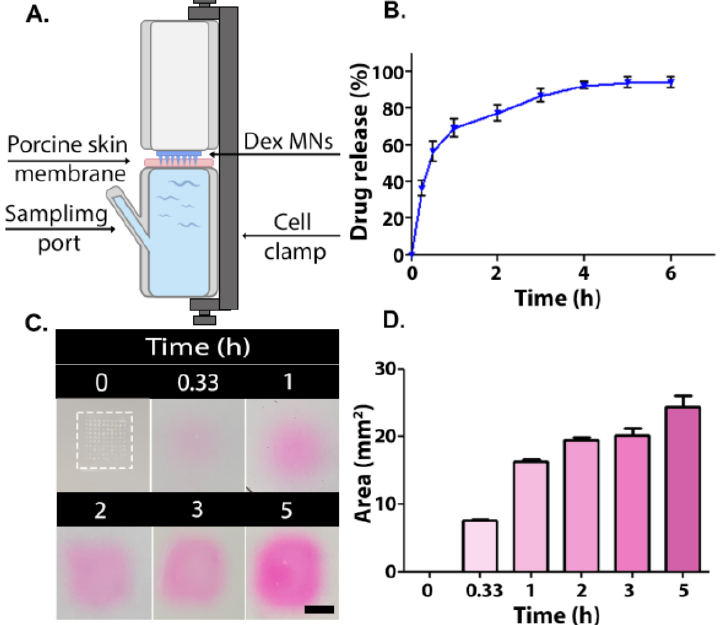
Figure 3. ( A ) Schematic illustration of a Franz di ff usion cell. Release of active ingredient from MNs: ( B ) In vitro Dex release profile from 1:2 PVA/PVP microneedles (n = 4). ( C ) Gel images of rhodamine B release in pig skin gelatin (Microneedle is enclosed by dashed box). Scale bar: 50 mm. ( D ) Rhodamine B di ff usion area measured by ImageJ.